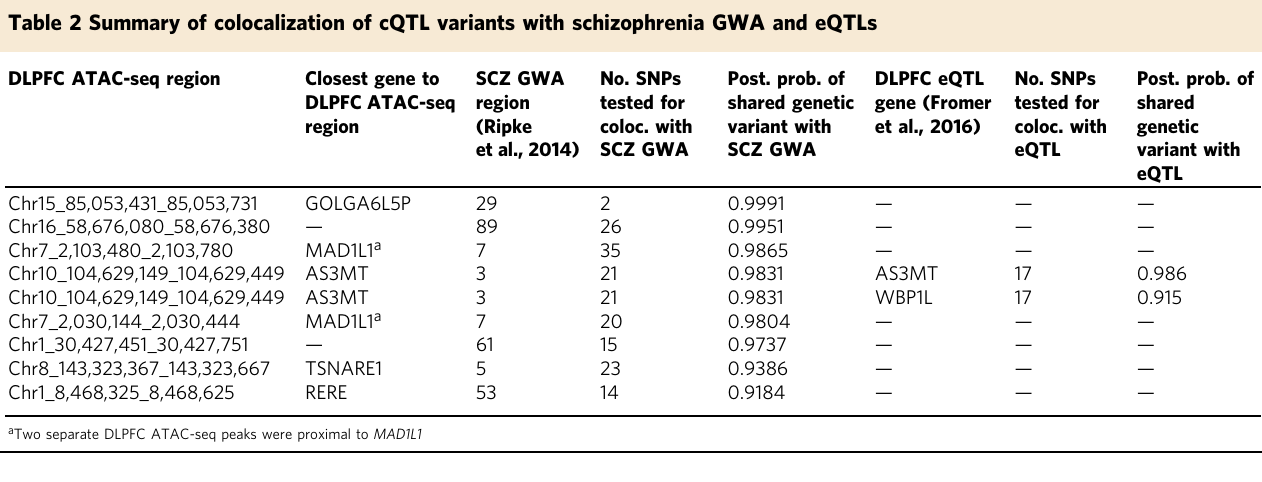
Table 3 Summary of results pertaining to schizophrenia genomic fi ndings Empirical fi ndings Evidence Regions that are both conserved and in open chromatin are enriched for transcription factor binding